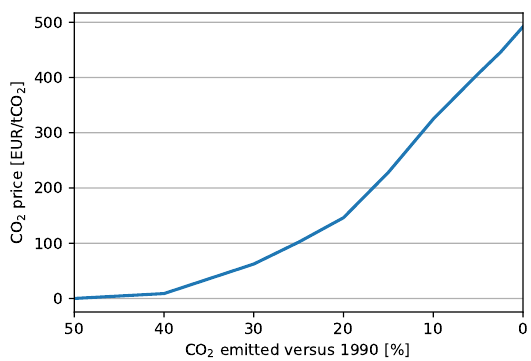
Figure 4. CO 2 shadow price in the model as CO 2 emissions are restricted in the case of cost-optimal cross-border